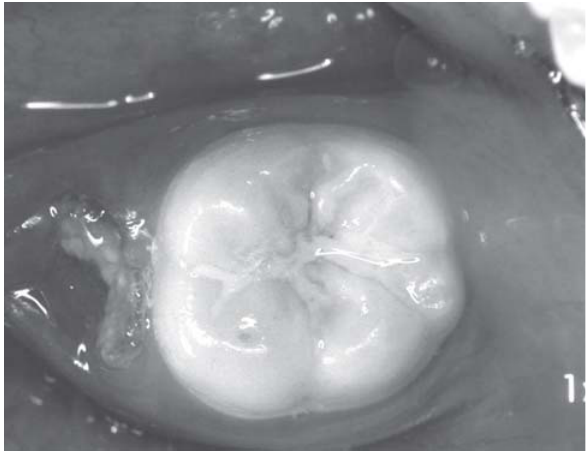
Figure 9- At 6-month recall, the presence of a fistula at buccal surface